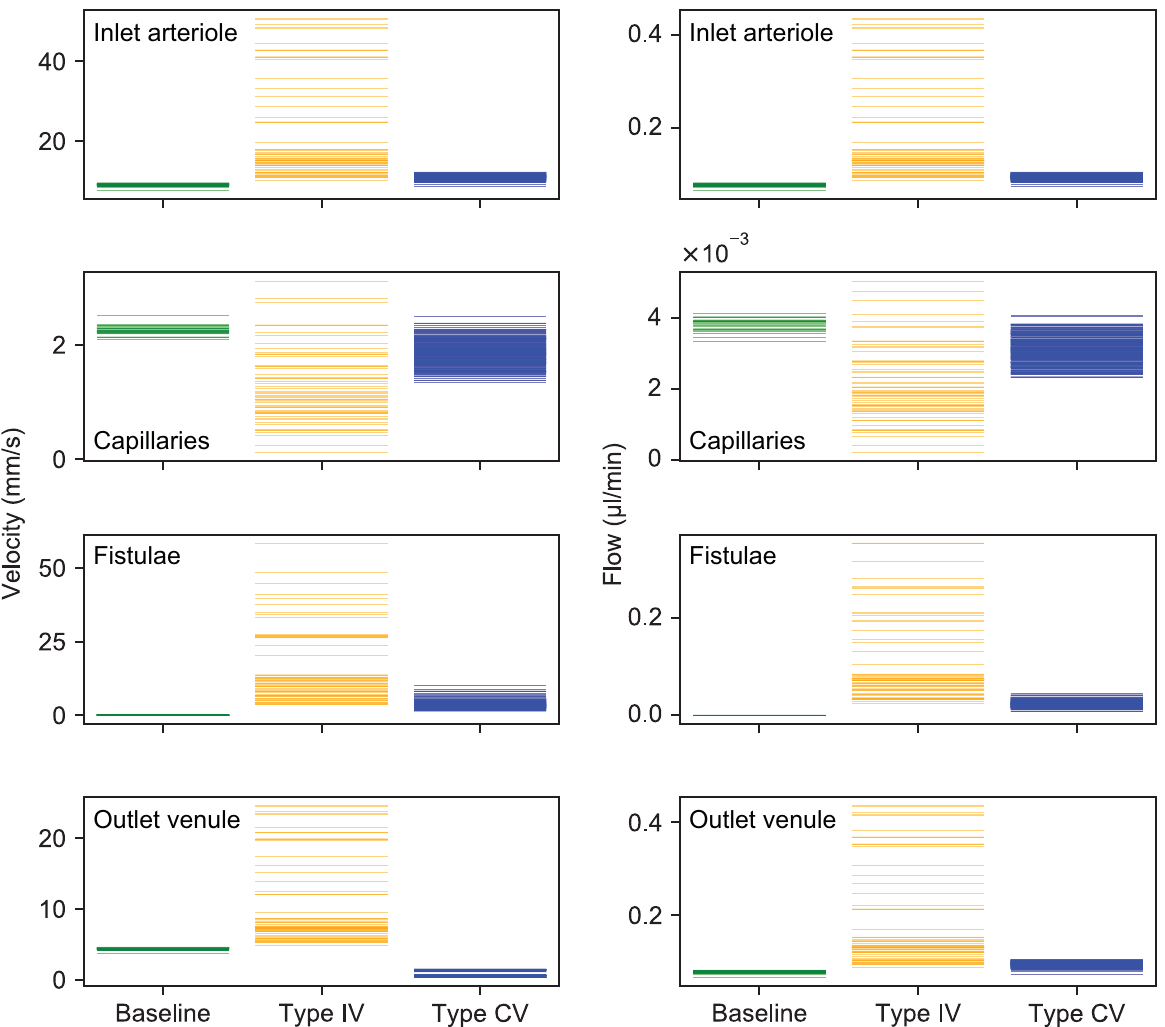
Fig 4. Hemodynamic parameters of computational AVM models. Temporal mean of blood flow velocities (left column) and flow rates (right column) in the inlet arteriole (first row), capillary bed (second row, mean value over all capillaries), fistulous vessels (third row, maximum value over all fistulae) and outlet venule (fourth row) for all computed prototypes. Each solid line represents one prototype baseline (green), type IV (orange) and type CV (blue) configuration.